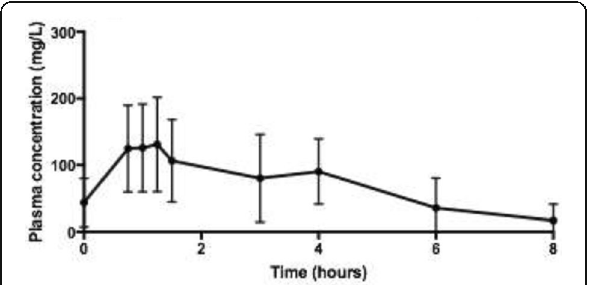
Fig. 1 (abstract 0020). Mean +/- standard deviation of piperacillin plasma concentration over